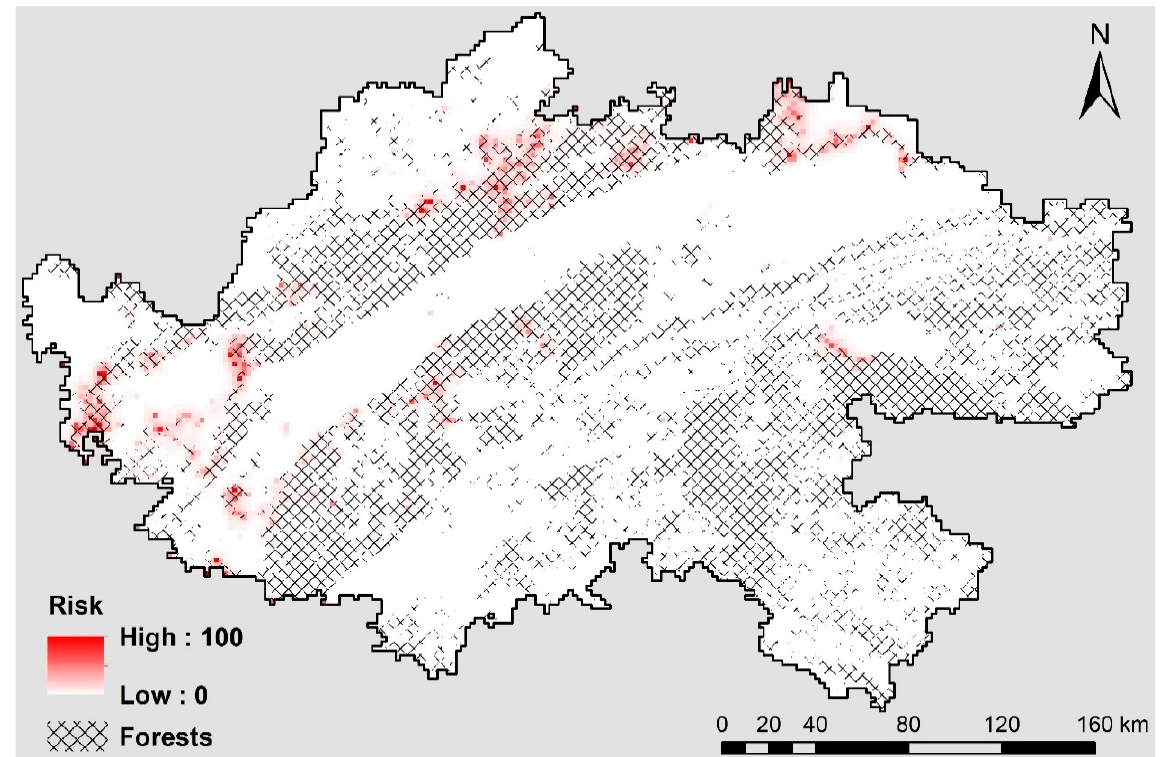
Figure 10. High-risk areas for human-influenced antelope mortality.